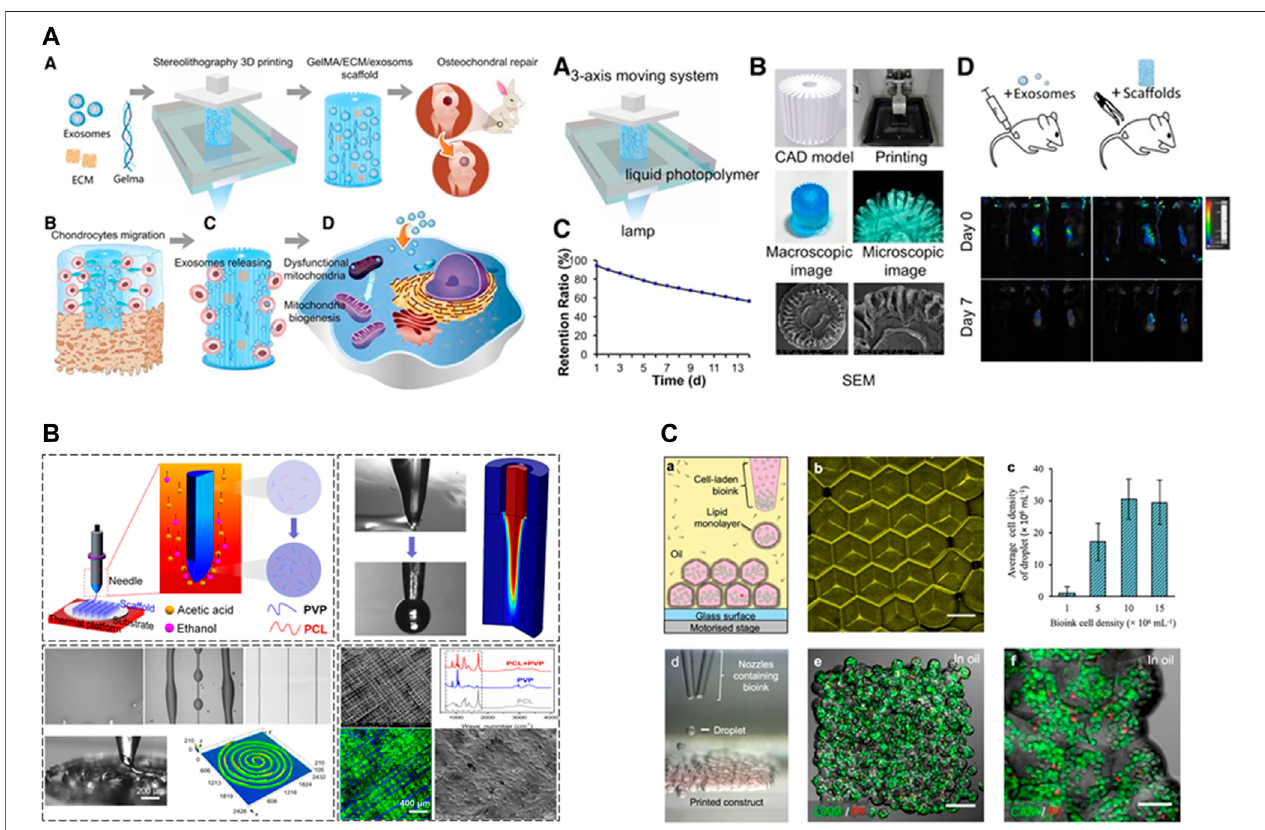
FIGURE 5 | Recent new technologies for 3D printing. (A) desktop-stereolithography 3D printing. Reproduced with permission (Chen et al., 2019b). Copyright: © 2019byIvyspringInternationalPublisher. (B) Tip-ViscidElectrohydrodynamicJet(TVEJ)3DPrinting.Reproducedwithpermission(Lietal.,2021).Copyright: © 2021by the authors. (C) 3D printing of aqueous droplets. Reproduced with permission (Graham et al., 2017). Copyright: © 2017 by the authors.